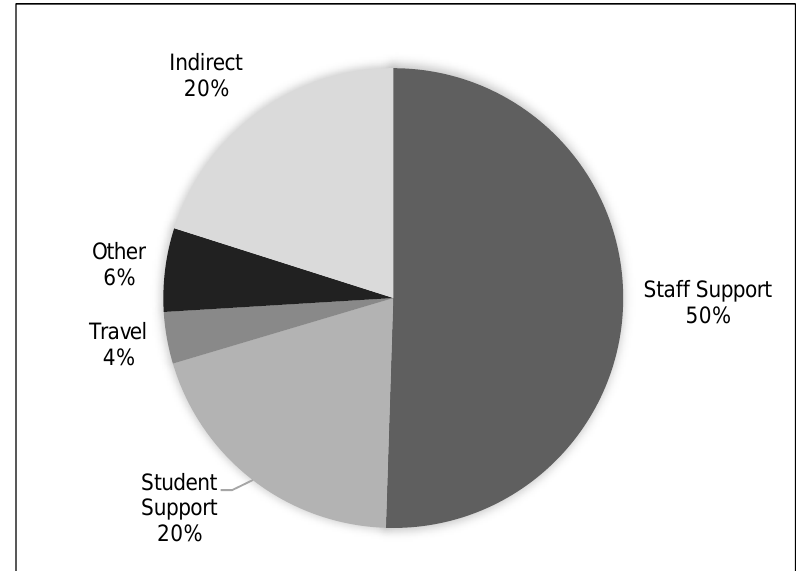
Figure 2. Spending of the Food Dignity Grant by Category by the University of Wyoming and Cornell University, 2011–2018 Although the University of Wyoming’s overall spending was higher than Cornell University’s (US$1,108,000 versus US$882,900), they had similar proportional spending by category, so their spending is combined here (total budget of